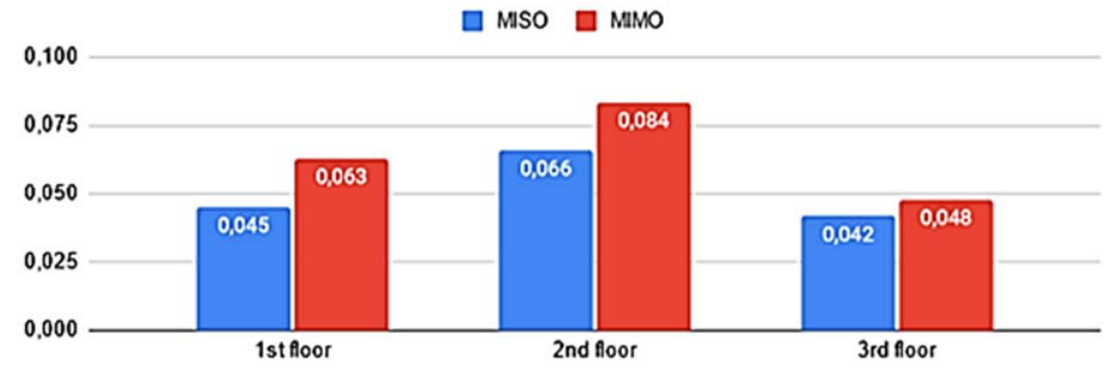
Figure 29. Average RMSE WRT approach for validation set and 2 h prediction horizon.